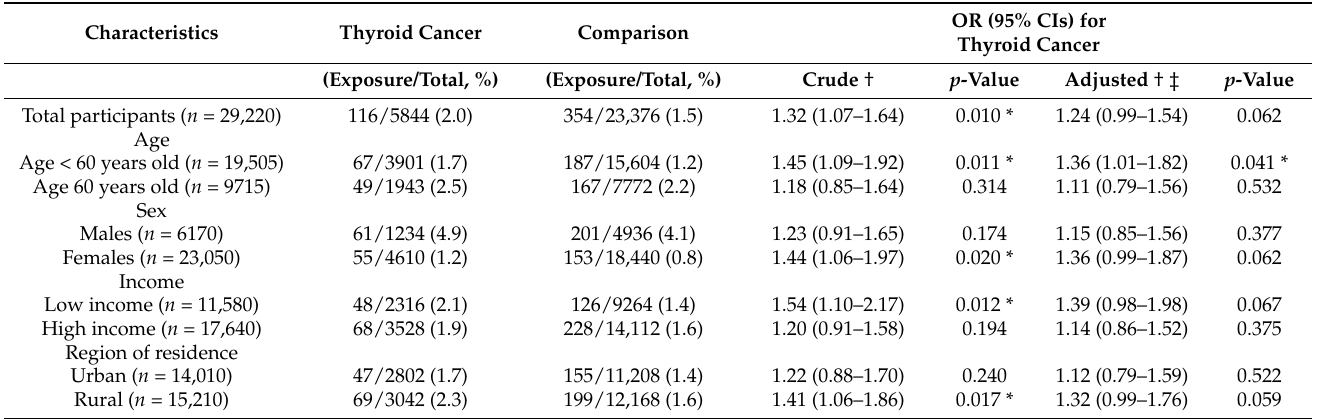
Table 2. Crude and adjusted odds ratio (95% confidence interval) of gout for thyroid cancer with subgroup analyses according to age, sex, income, and region of